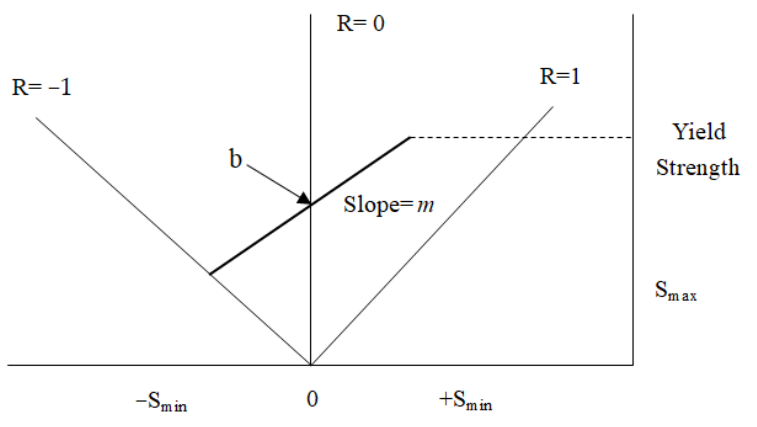
Figure 3. Goodman curve.